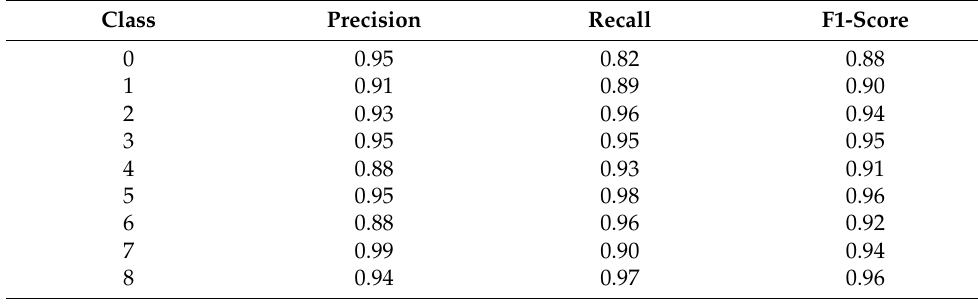
Table 1. KNN classification model